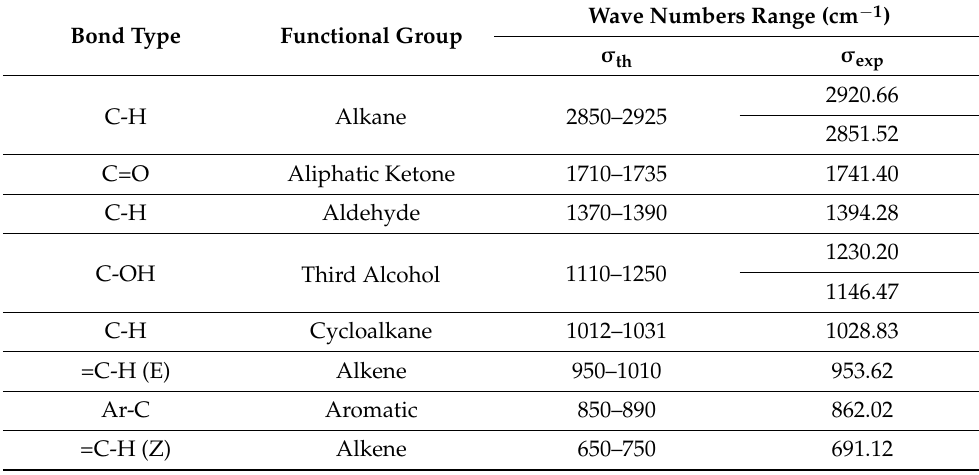
Figure 1. FTIR (Fourier transform infrared spectroscopy) spectra. Table 1. FTIR analysis of WHAC.